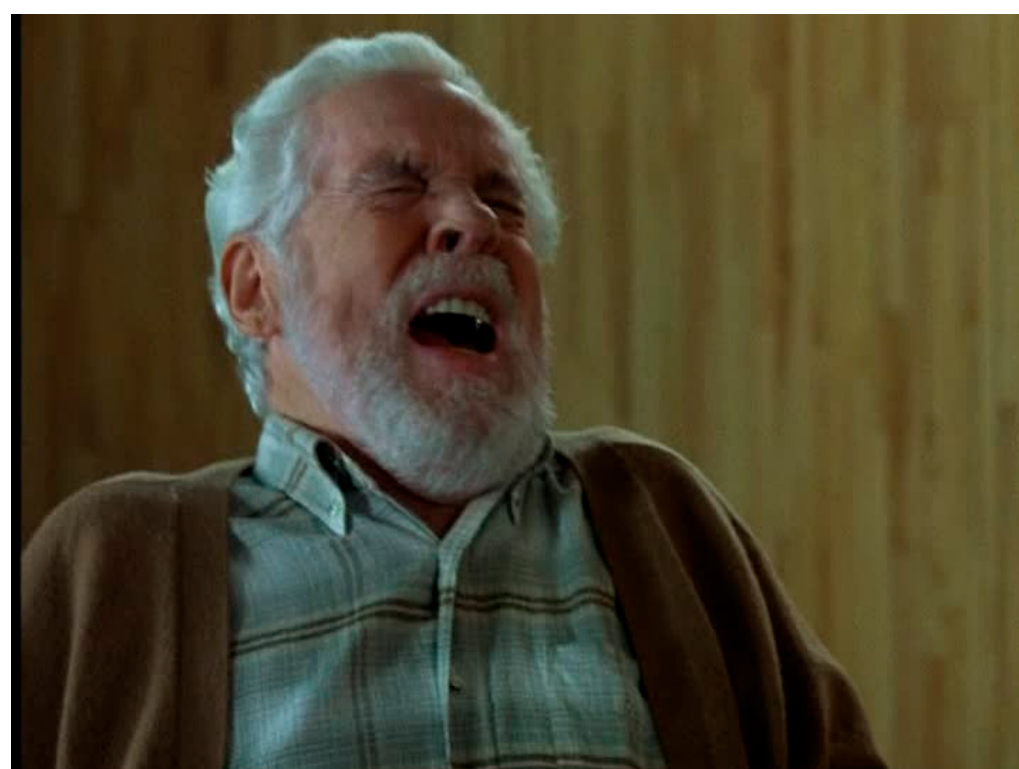
Figure 14. Reflexive Touch: Bergman/David.